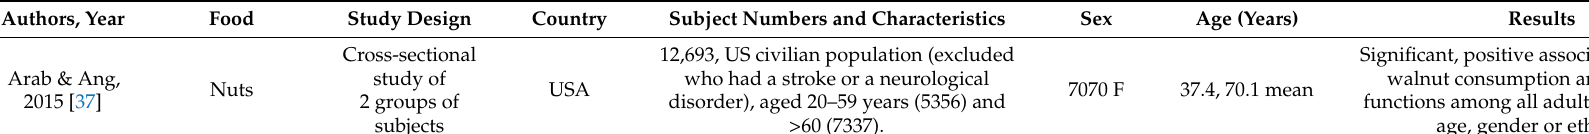
Table 2. Studies included in the final pool for